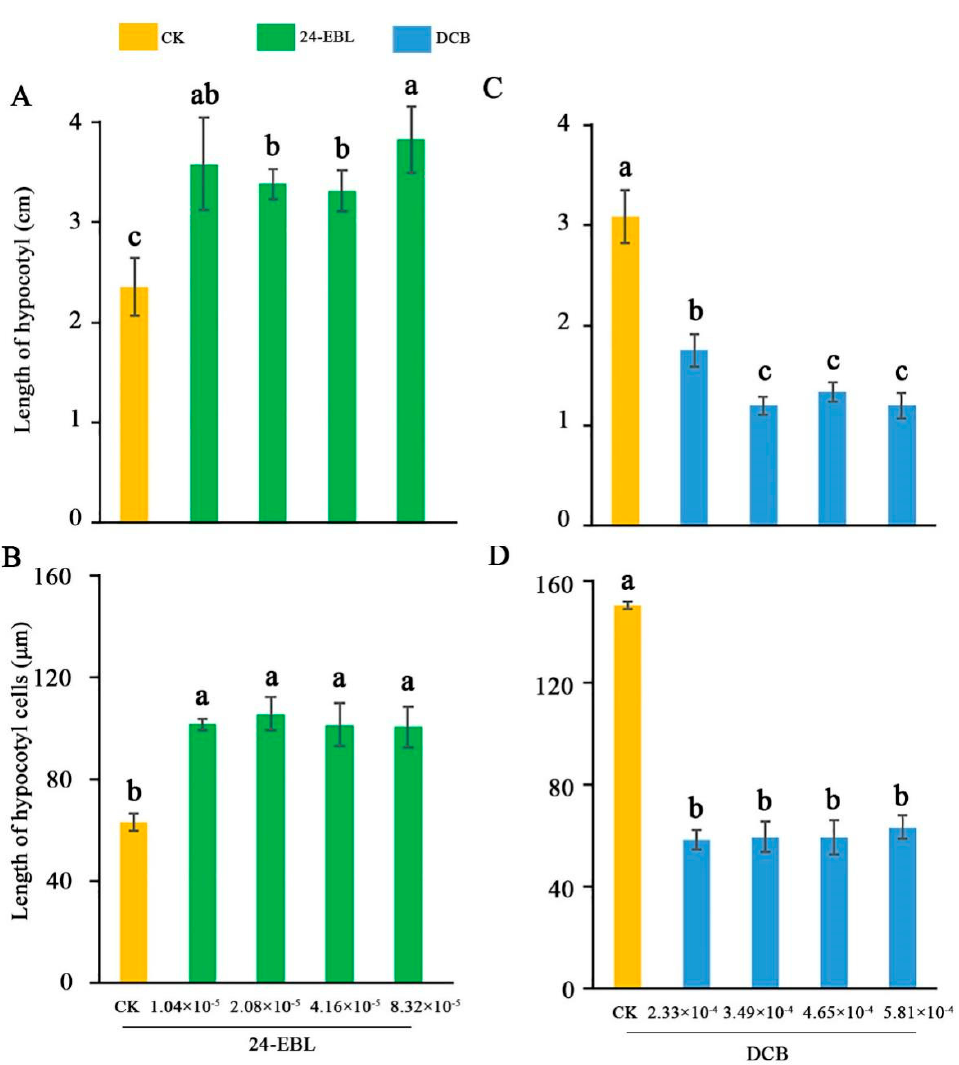
Figure 5. Effect of 24-EBL/DCB treatments on the lengths of hypocotyl and hypocotyl cells in celery. ( A , B ) 24-EBL treatment groups; ( C , D ) DCB treatment groups. Column diagrams with different colors represent the data from celery plants in CK, 24-EBL and DCB treatment groups. Data are expressed as the means ± standard deviation (SD) of three replicates. Different letters indicate significant difference at 0.05 level.